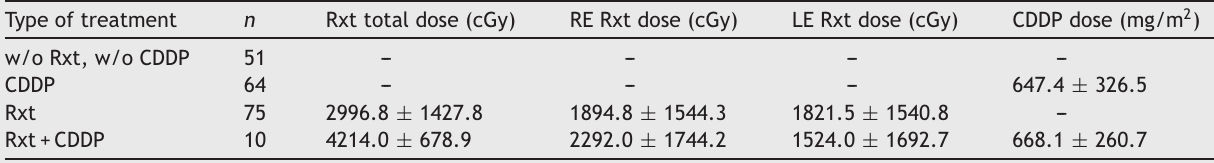
Means and standard deviations of the radiation dosage (Rxt) and of cisplatin (CDDP) used according to the type of treatment for the right (RE) and left (LE) ear (GEPETTO 2000---2004). Type of treatment n